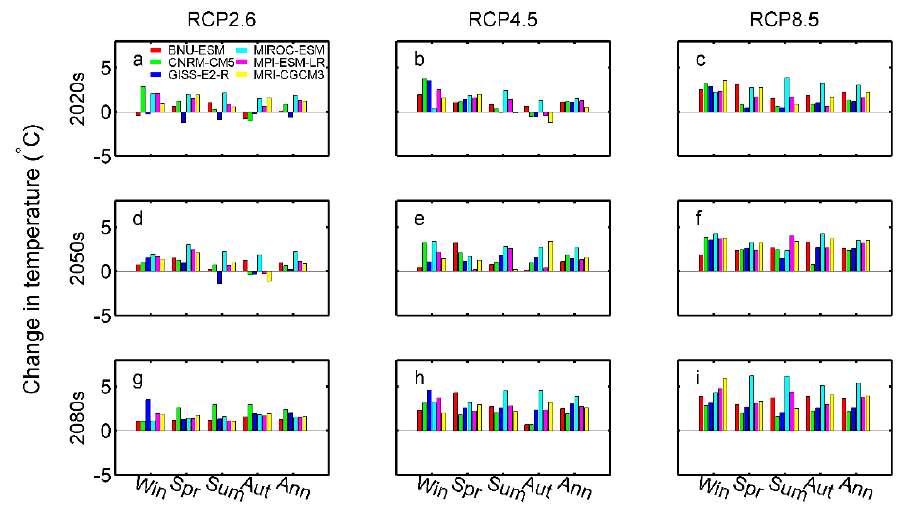
Figure 6. Changes in seasonal temperature (°C) in the future periods (2020s, 2050s and 2080s) under RCP 2.6, RCP 4.5 and RCP 8.5: ( a ) 2020s under RCP2.6; ( b ) 2020s under RCP4.5; ( c ) 2020s under RCP8.5; ( d ) 2050s under RCP 2.6; ( e ) 2050s under RCP4.5; ( f ) 2050s under RCP8.5; ( g ) 2080s under RCP2.6; ( h ) 2080s under RCP4.5; ( i ) 2080s under RCP8.5.